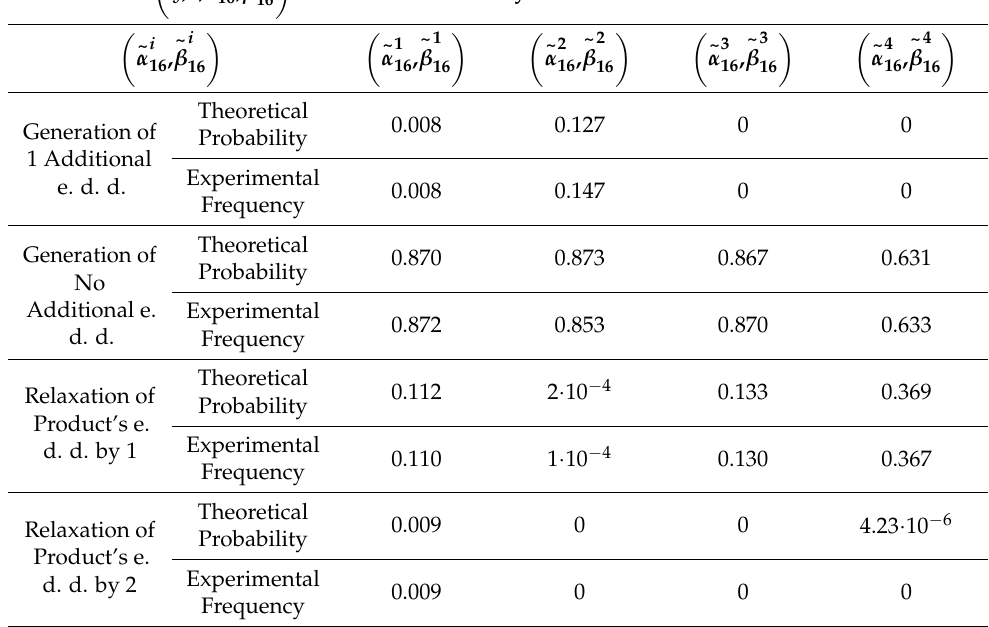
(cid:16) (cid:17) − (cid:101) β i 16